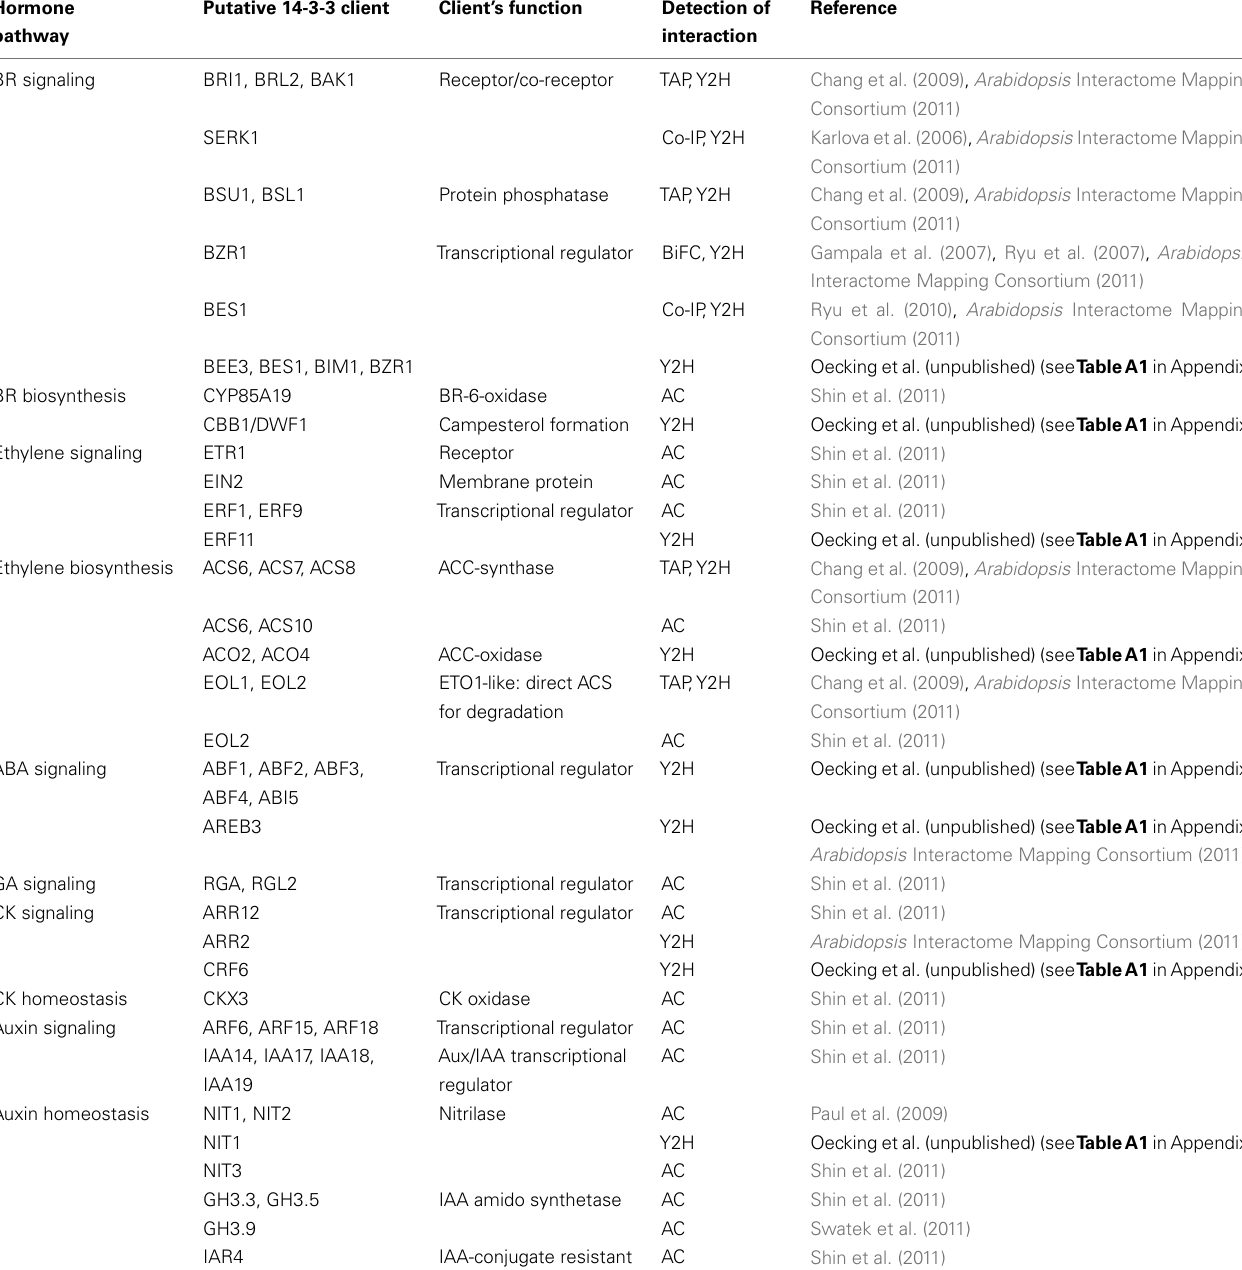
Table 2 |A summary of recently identified putative Arabidopsis 14-3-3 interactors involved in phytohormone signaling or